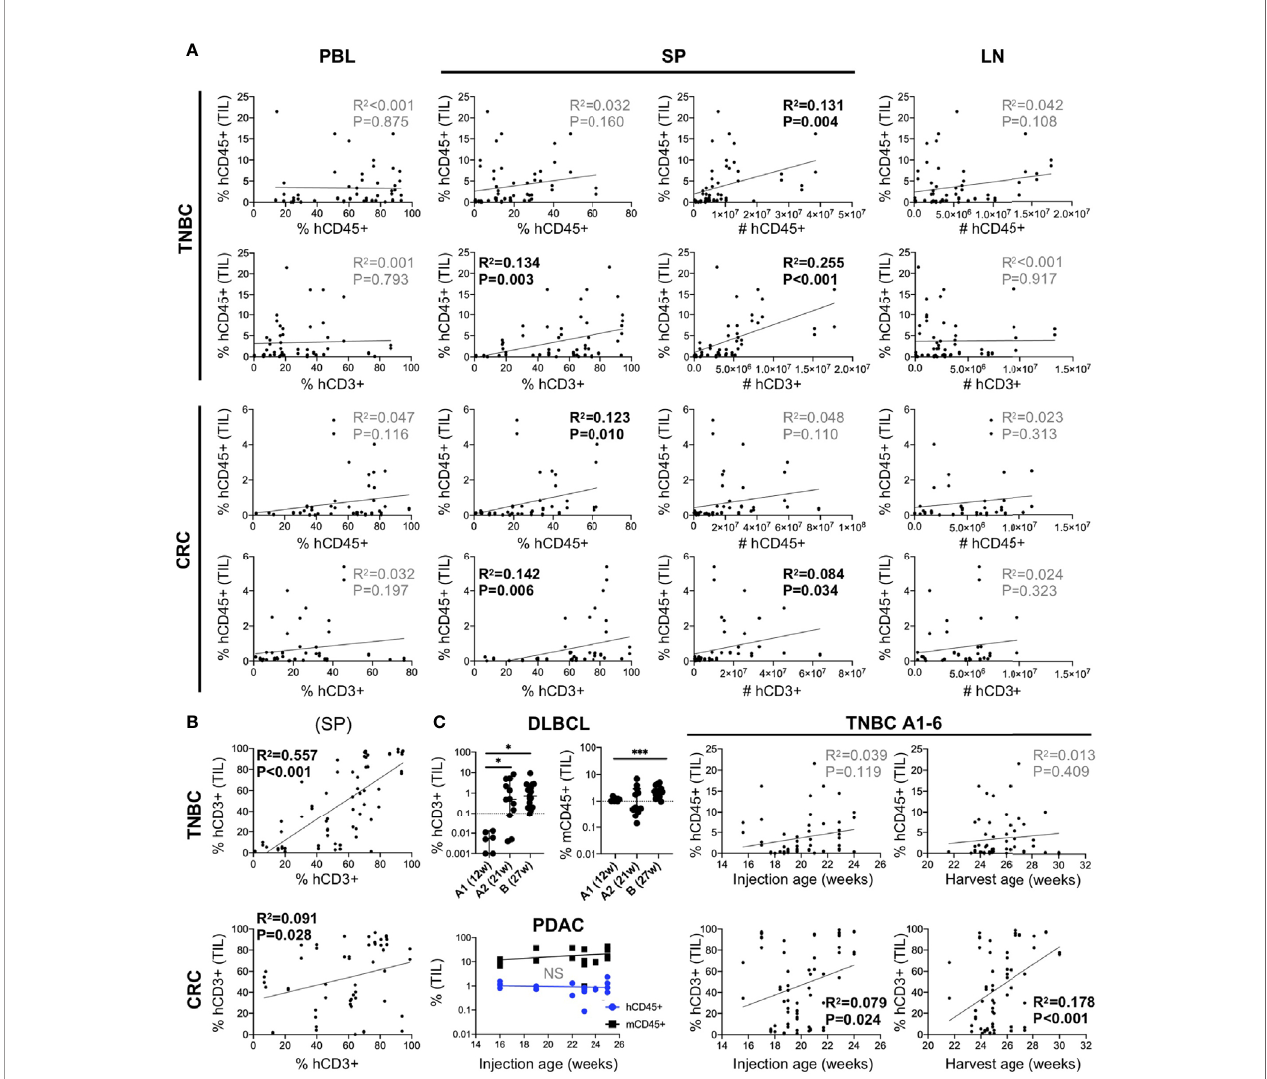
FIGURE 5 | In fl uence of human chimerism and timing of tumor injection on human immune in fi ltration in human tumors in untreated HIS-BRGS-mice. (A) Correlation of hCD45 + in fi ltration in HIS-BRGS tumors with human chimerism in lymph organs. Data from six TNBC CDX (top, A1-A6) and fi ve CRC (bottom, CRC B2, D2, D3, E, F) independent experiments. hCD45 and hCD3 chimerism (percentage and absolute number, #) in PBMC prior to tumor injection (PBL at 15 weeks), and in the spleen (SP) and lymph nodes (LN) at end of study. (B) Positive correlation between T cell in fi ltration in TNBC A1-A6 and CRC tumors (B2, D2, D3, E, F) and T cell chimerism in spleens of HIS-BRGS mice. (C) In fl uence of timing of tumor injection on human immune cell in fi ltration into tumors. Human (hCD45+) or T (hCD3 + ) and mouse (mCD45 + ) immune cell in fi ltration into DLBCL CDXs ( upper left ) or PDAC PDX (lower left) with different tumor injection timepoints. Correlation of hCD45+ and hCD3 + in fi ltration into untreated TNBC CDXs (A1-A6) and the age of HIS-BRGS mice at time of tumor injection or end of study ( right ). * p < 0.05, ***p < 0.001 [ A, B : Linear regression analysis, R-squared score (R 2 ) and P value (P) in bold if statistically signi fi cant (P < 0.05); (C) : Welch ’ s two-group t-test, two-tailed between organs as indicated by edges of each